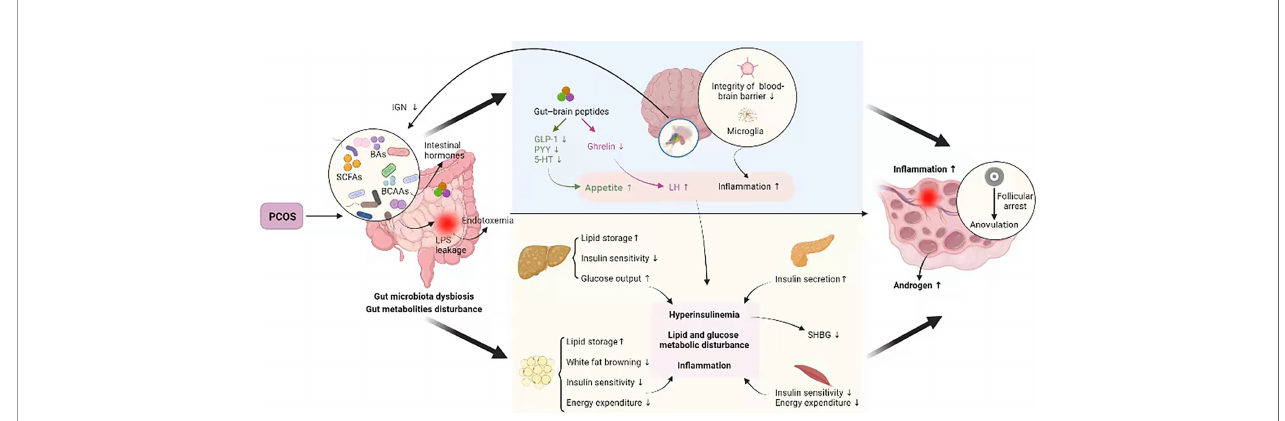
FIGURE 1 | Crosstalk between PCOS and gut metabolites. PCOS, polycystic ovary syndrome; BAs, bile acids; SCFAs, short-chain fatty acids; BCAAs, branched- chain amino acids; IGN, intestinal gluconeogenesis; LPS, lipopolysaccharide; GLP-1, glucagon-like peptide 1; PYY, peptide YY; 5-HT, 5-hydroxytryptamine; LH, luteinizing hormone; SHBG, sex hormone – binding globulin. PCOS disturbs intestinal microbial homeostasis and metabolites, which may be linked to the insulin signaling pathway, steroid hormone levels, glucose metabolism, lipid metabolism, and immunological homeostasis etc., all of which are involved in PCOS pathogenesis, thus forming a vicious